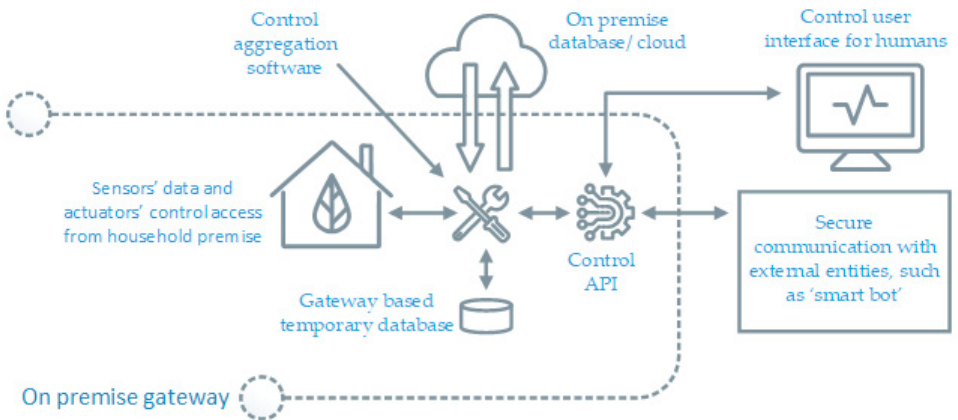
Figure 1. A concept block diagram for aggregation of all actuator hardware controls on premise-based internet enabled gateway computer.